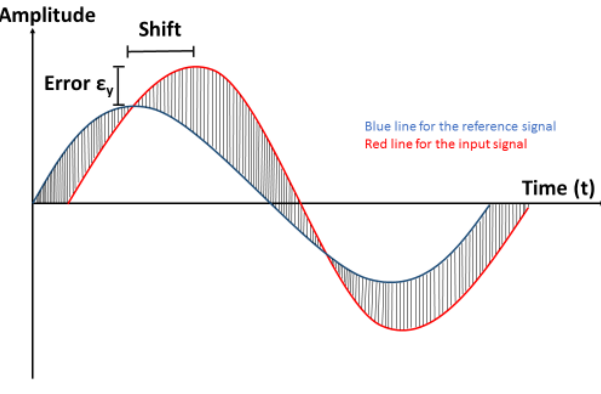
Figure 8. Alignment error ε(t) and Shift error.